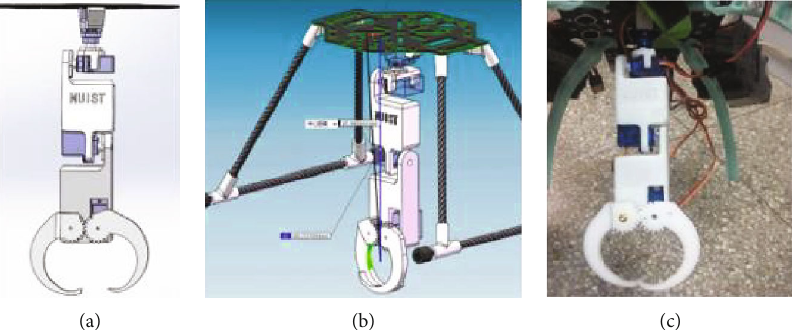
Figure 4: UAV robot arm design. (a) Design drawings. (b) Installation schematic. (c) Physical picture.